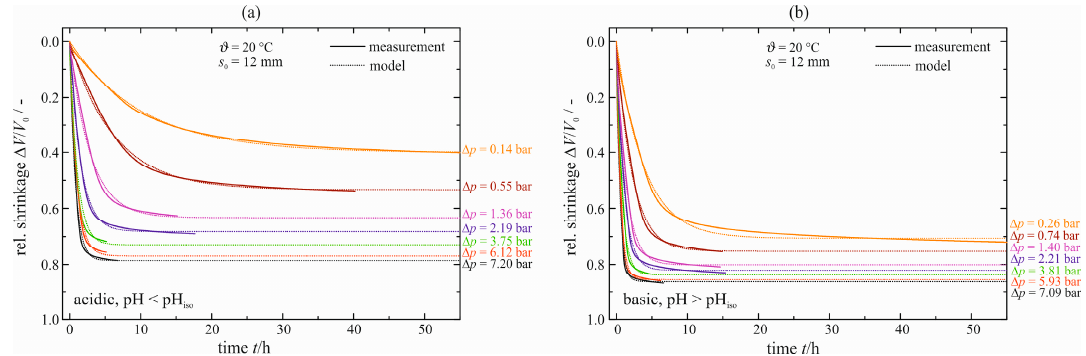
Figure 14. Relative shrinkage Δ V / V 0 of enforced syneresis for s 0 = 12 mm and ϑ = 20 °C, acid-catalyzed ( a ) and base-catalyzed ( b ).